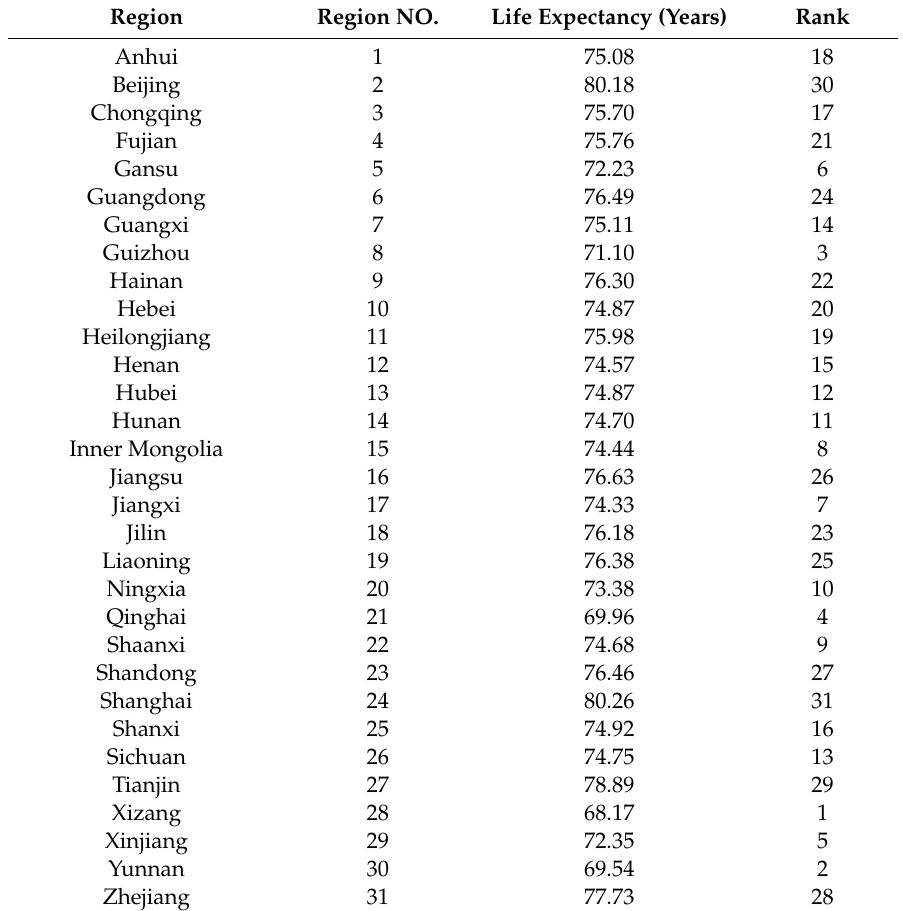
Table 3. Table of dependent